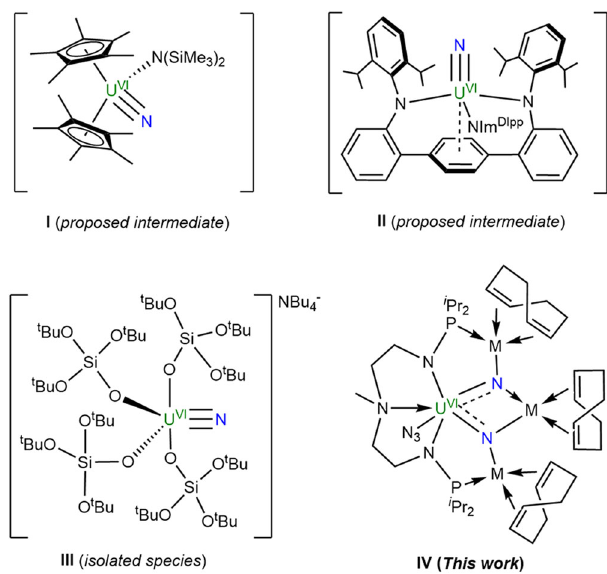
Fig. 1 U(VI) nitrides generated by the photolysis of uranium azides. Both I and II are proposed U(VI) nitride intermediates. Complex III is an isolated example of U(VI) nitride species. Complex IV is a U(VI) nitride stabilized by transition